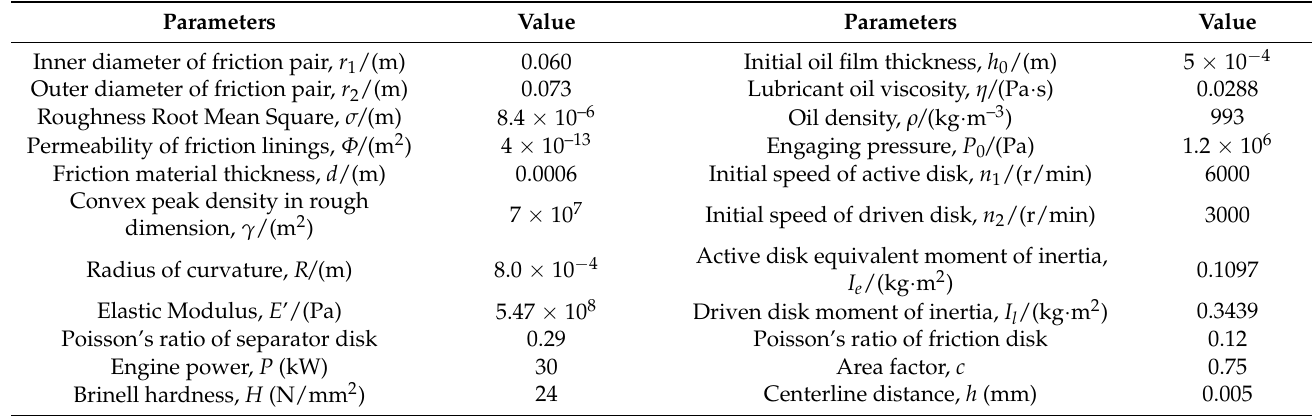
Table 1. Simulation parameters of the paper-based three-way parallel groove friction